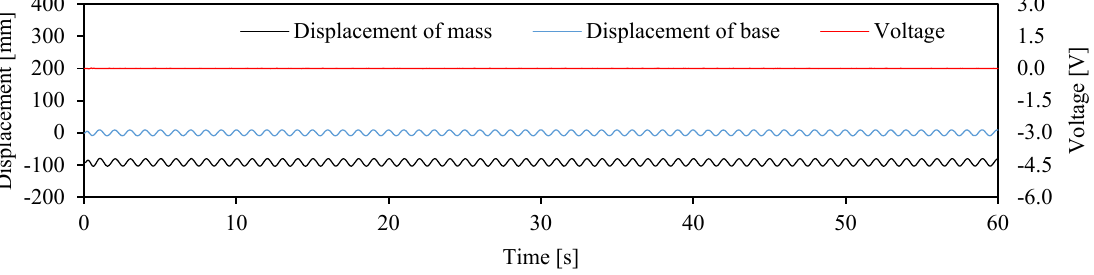
Figure 11. Measurement results for 1.0 Hz periodic signal excitation. No relative displacement was observed between the mass block and support point, as they both vibrated periodically simultaneously and did not generate power when vibrating at a low frequency such as 1.0 Hz, as shown in Figure 11. The standard deviations of the vibration displacements of the mass block and support point were 7.93 and 6.35 mm, respectively, which resulted in 0.00 mW power